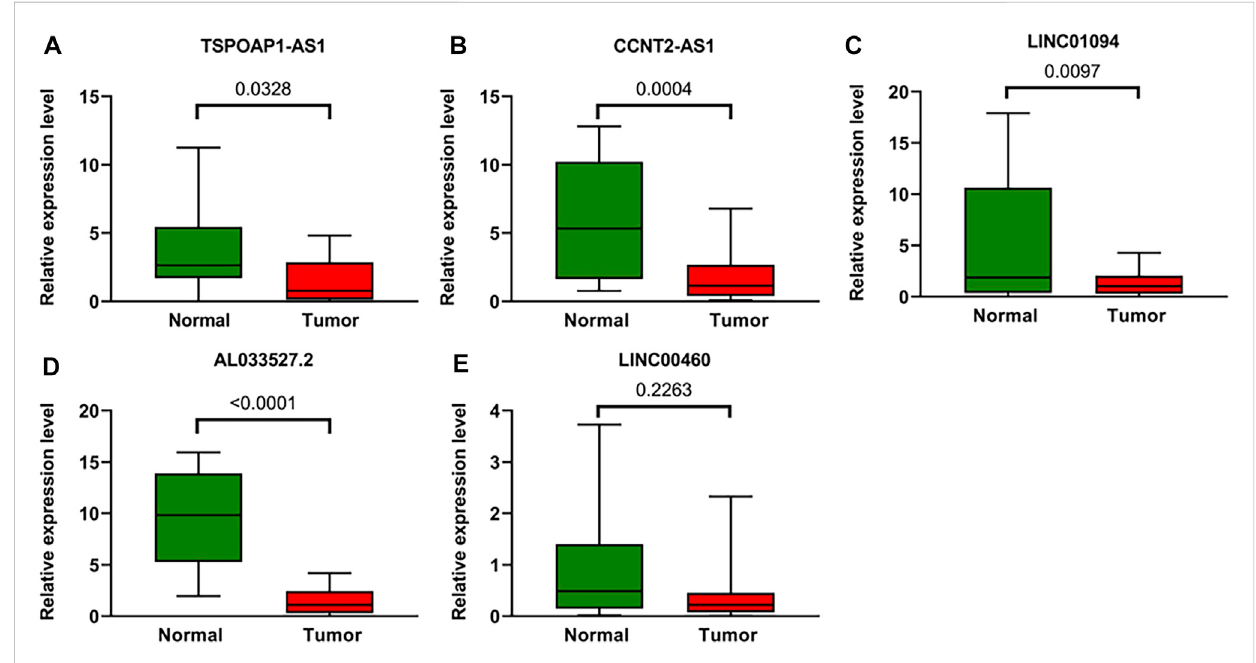
FIGURE 10 Validation of the expression Levels of lncRNAs of prognostic signature. (A – E) TSPOAP1-AS1, CCNT2-AS1, LINC01094, AL033527.2, and LINC00460 expressions in gastric cancer tissues compared with corresponding normal tissues from patient